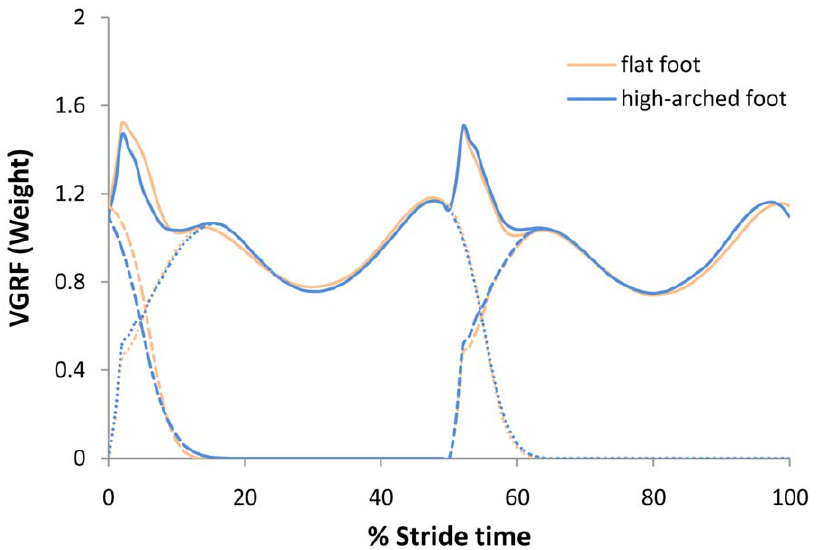
Figure 1. Relationships between the forces and time. The blue (deep) dotted lines refer to the VGRFs of the high-arched left and right foot while the blue (deep) solid line refers to the resultant force of the high-arched. The red (light) dotted lines stand for the VGRFs of the flat left/right foot while the red (light) solid line for the resultant force of the flat foot. The VGRFs were obtained from the test report of Zebris FDM, the resultant force from F sum t ð Þ ~ F left t ð Þ z F right t z t o